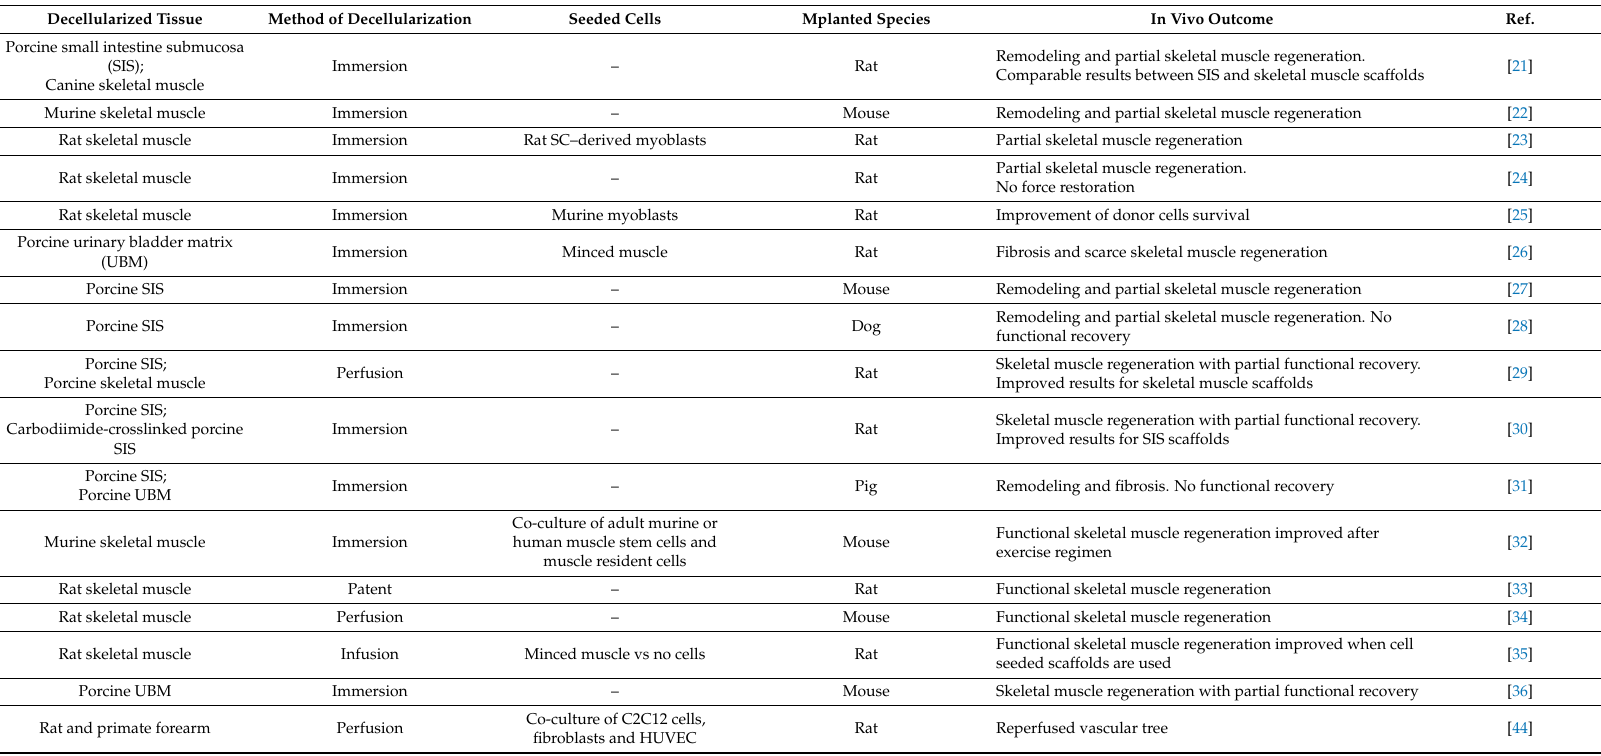
Table 1. Decellularized tissues used in vivo. The table reports the studies in which decellularized tissues have been applied in vivo. The type of decellularized tissues, the method of decellularization, the type of the eventual seeded cells, the species subject to implantation, and the in vivo outcome have been reported for each reference. –, not